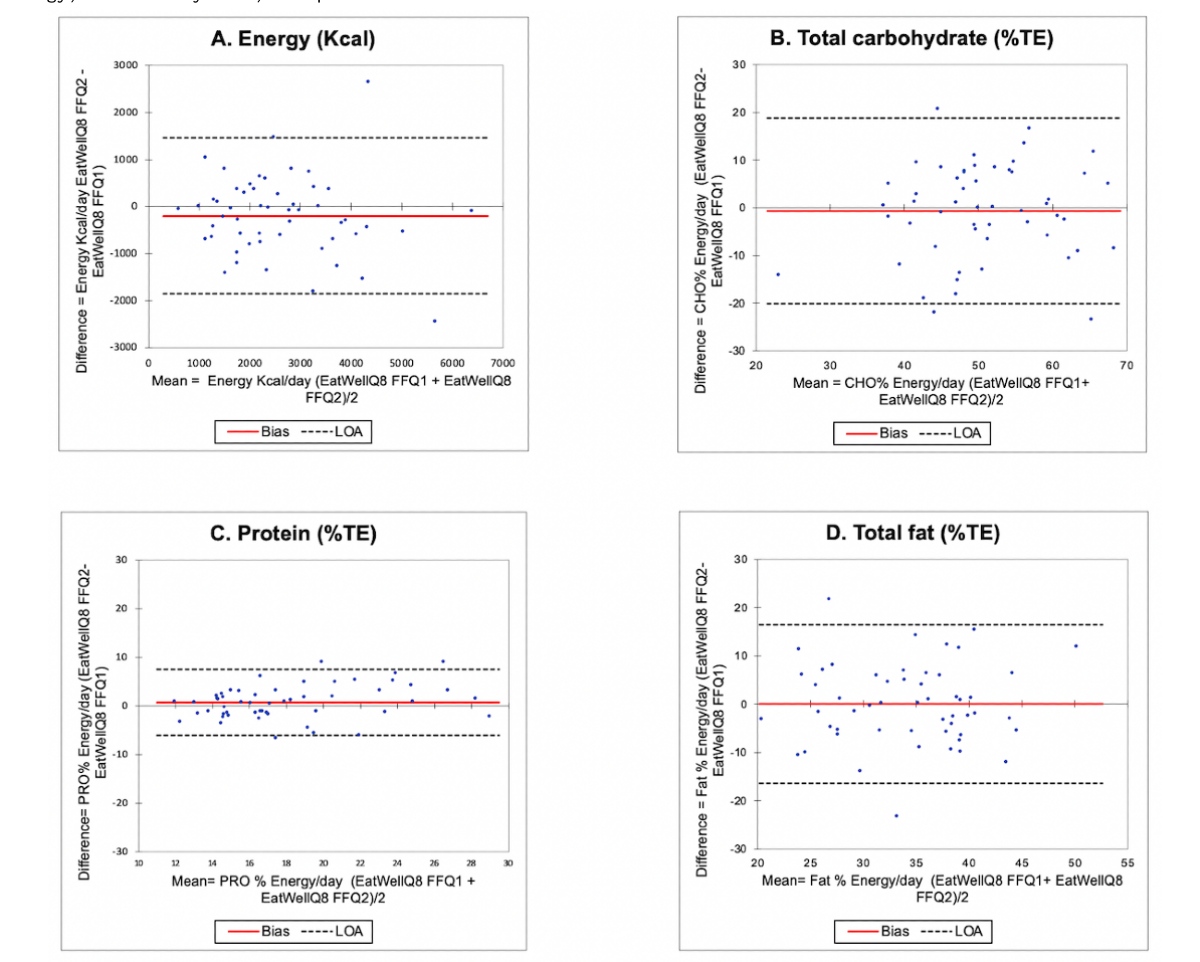
Figure 3. Reproducibility study of Bland-Altman plots for (a) energy, (b) total carbohydrate, (c) protein, and (d) total fat with the bias (mean difference) and limits of agreement. The solid line represents the bias (mean difference), and the dotted lines represent the limits of agreement. %TE: percentage total energy; CHO: carbohydrates; PRO: